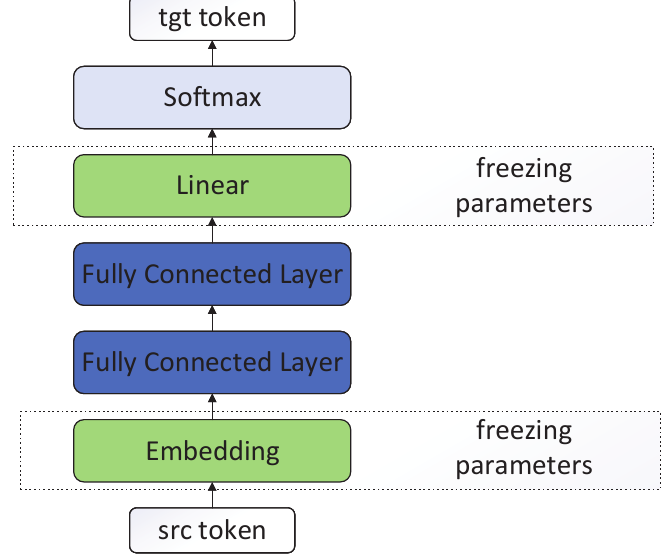
Figure 3. The model architecture of word translation model. The embedding layer and linear layer are initialized by the cross-lingual word embedding, and their parameters are frozen on the word translation